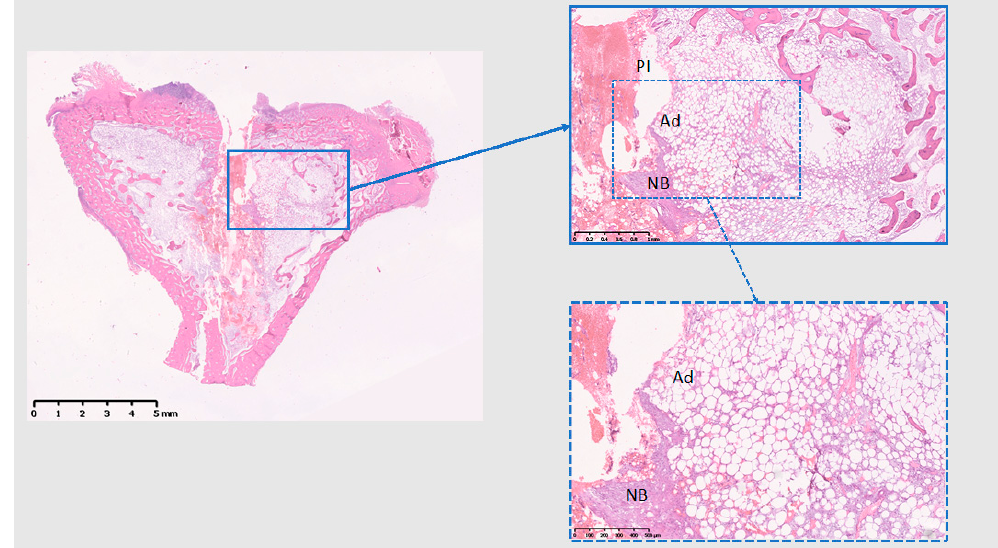
Figure 10. Histological analysis of PEEK (10 days). PI: PEEK implant; NB: New bone; Ad: Adipose tissue. Some collagen proliferation in one thread, adipose tissue also on the implant surface. Scale bars: 5 mm, 1 mm, and 500 µm.